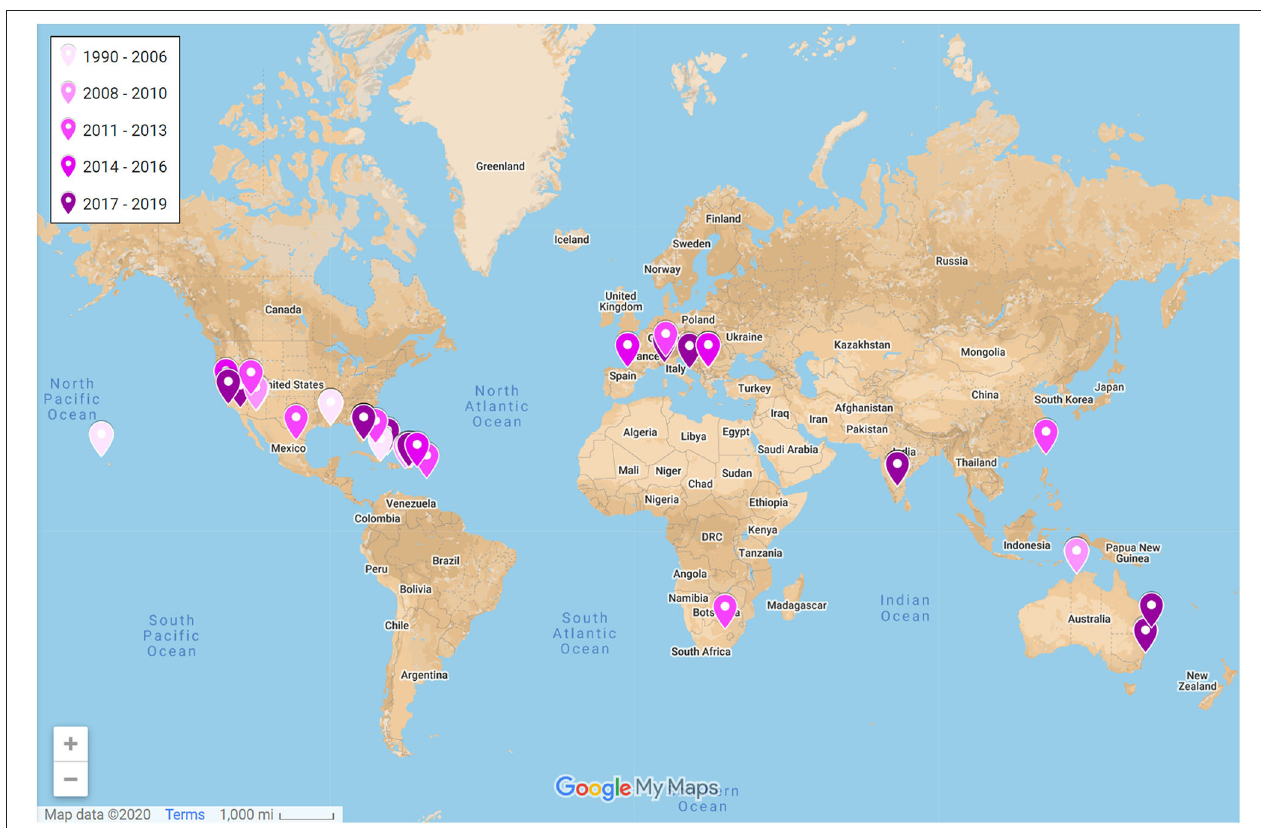
FIGURE 4 | Geographic locations of studies on urban lizards included in the qualitative synthesis ( N = 54). Points represent averaged centroids of urban replicate localities. Tags are colored by publication year; darker tags are more recent (range: 1990–2019). A full interactive evidence atlas can be found here: